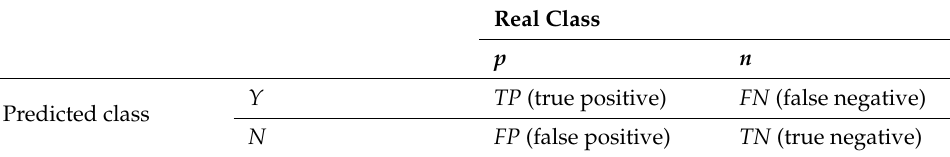
Table 1. Confusion